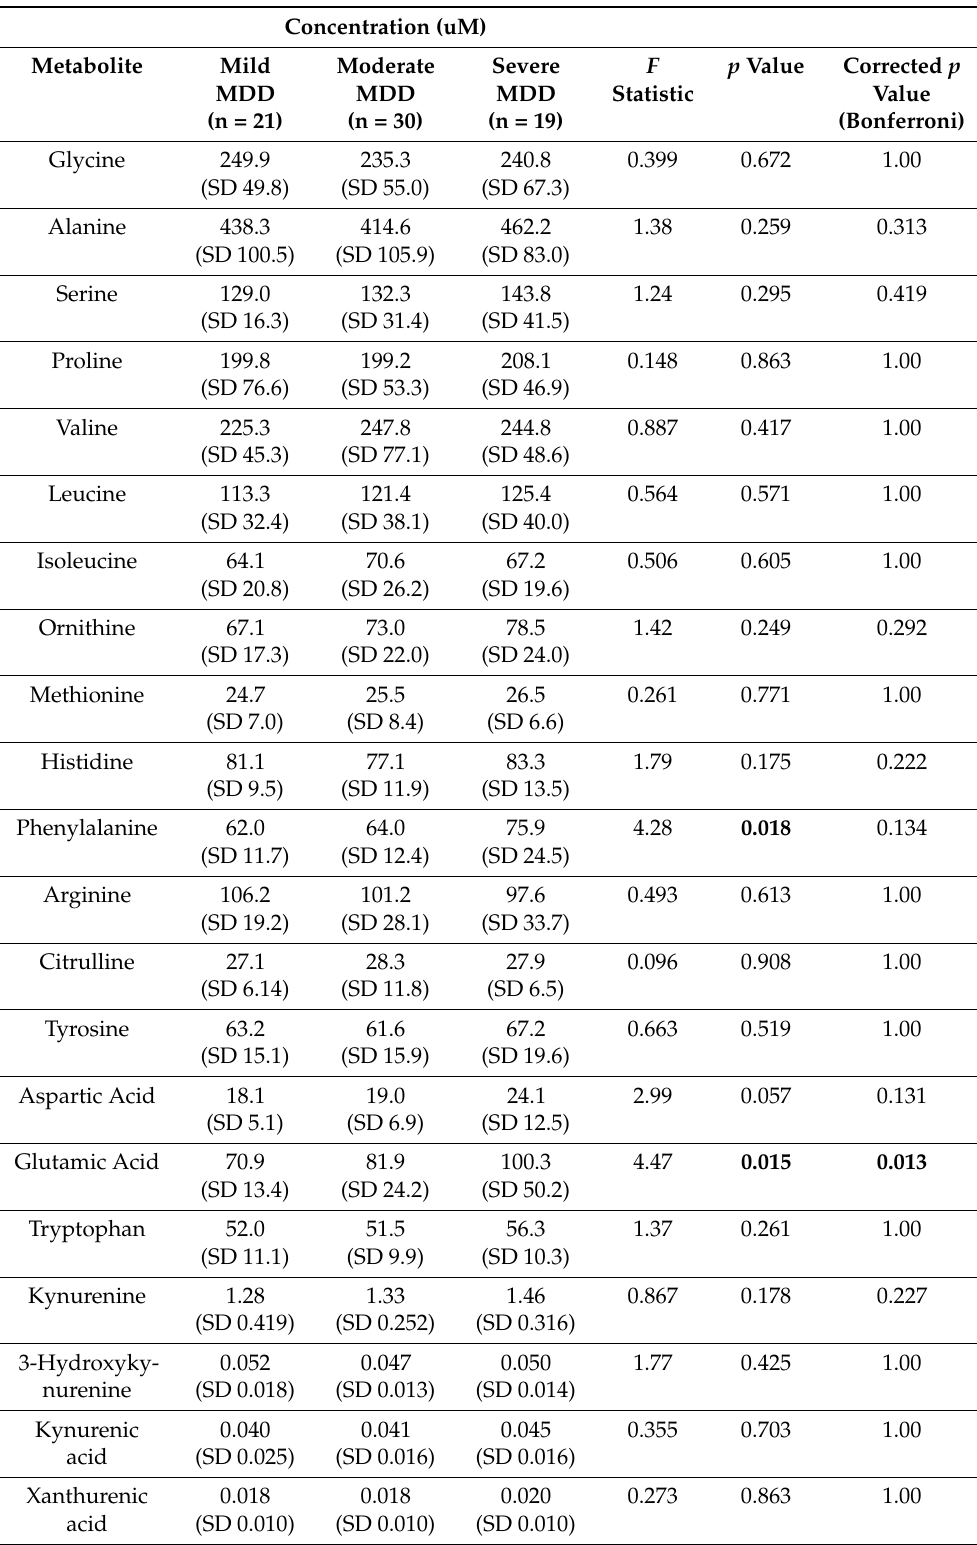
Table 3. Differences in mean metabolite concentrations of blood serum of patients with differing MDD